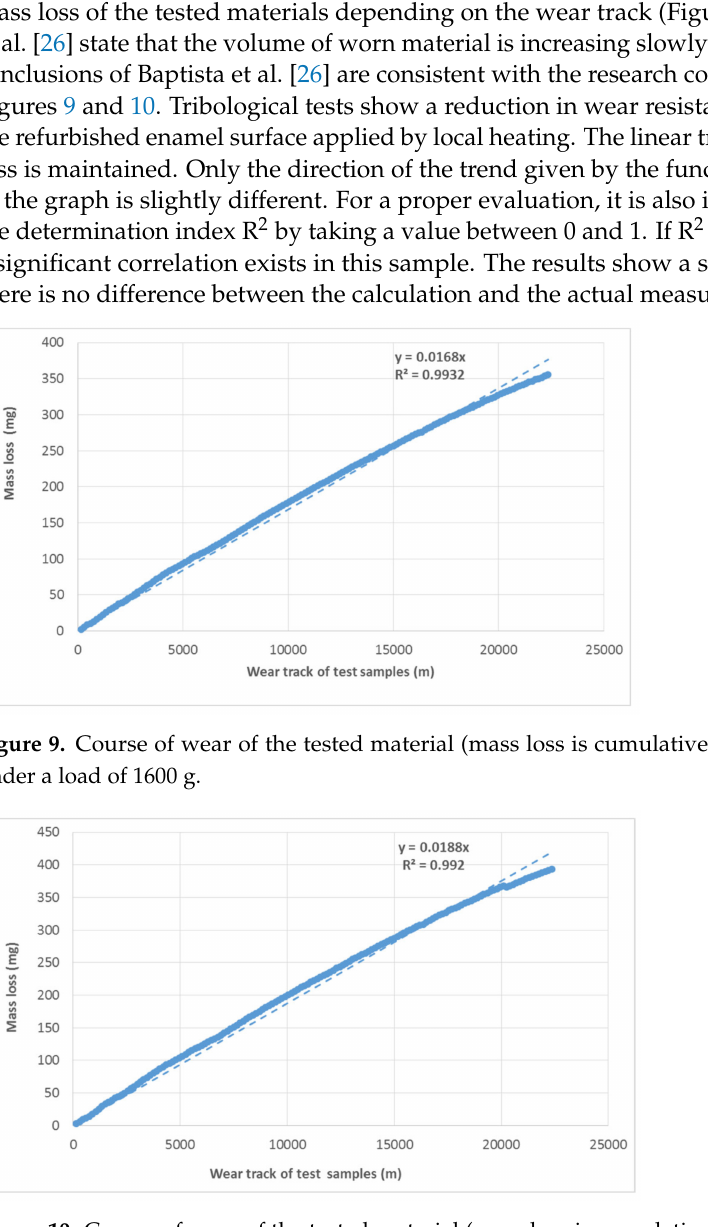
Figure 10. Course of wear of the tested material (mass loss is cumulative depending on the track) under a load of 1600 g on a renovated enamelled